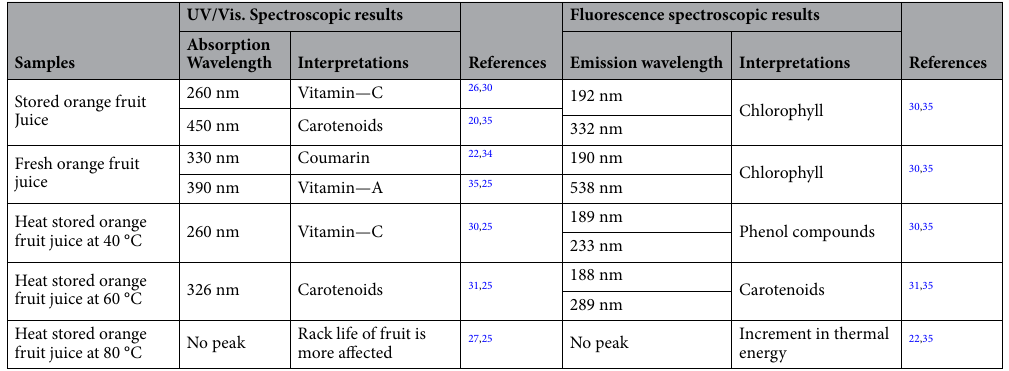
Table 2. UV/Vis and Fluorescence Spectroscopic results of stored, fresh and heat-treated orange fruit juices compared with various literature.